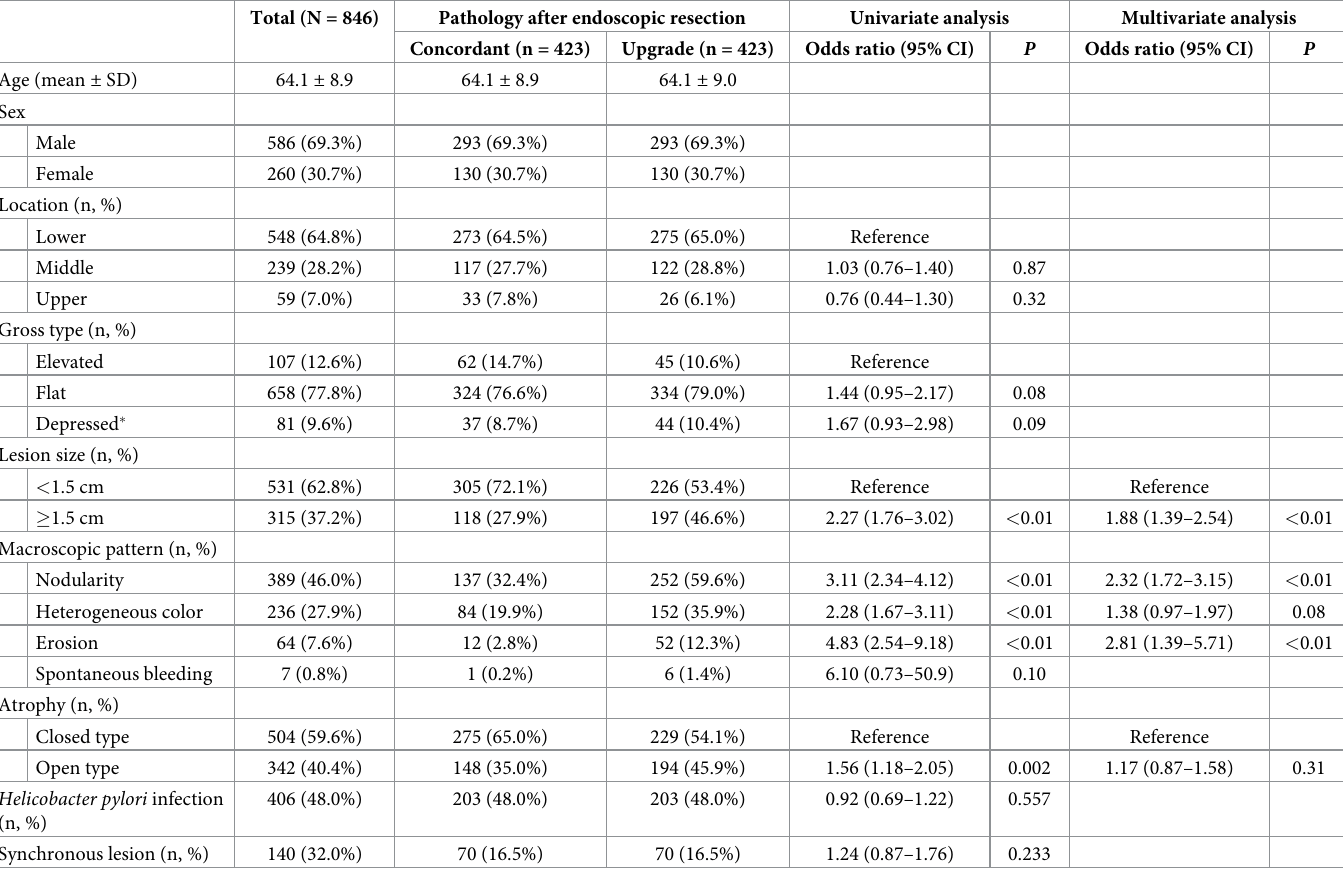
Table 1. Clinical and endoscopic characteristics of the pathologically concordant and upgraded groups after resection of gastric low-grade